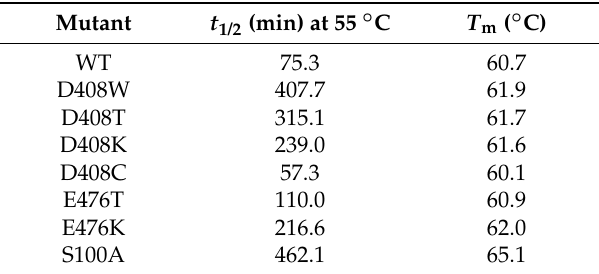
Figure 2. Thermostability of wild-type and mutant GOD m . ( a ) Residual activity of the wild-type GOD m and mutants after treatment at 55 °C for different times. Data points correspond to the mean values of three independent experiments. The activity of the untreated enzyme was considered as 100%; ( b ) Residual activities of the wild-type GOD m , S100A and D408W after incubation at 60 °C; ( c ) Optimum temperature of the wild-type GOD m and mutants. The highest activities of the mutants and wild-type GOD m were considered as 100%; ( d ) Temperature-induced unfolding measured with differential scanning calorimetry for the wild-type and mutant enzymes. The scans were fitted to a curve after subtraction of an instrument-derived baseline recorded with buffer in both holes as calculated using Origin software (Origin Lab, Northampton, MA, USA). Table 1. Thermostability of the wild-type and mutant enzymes.